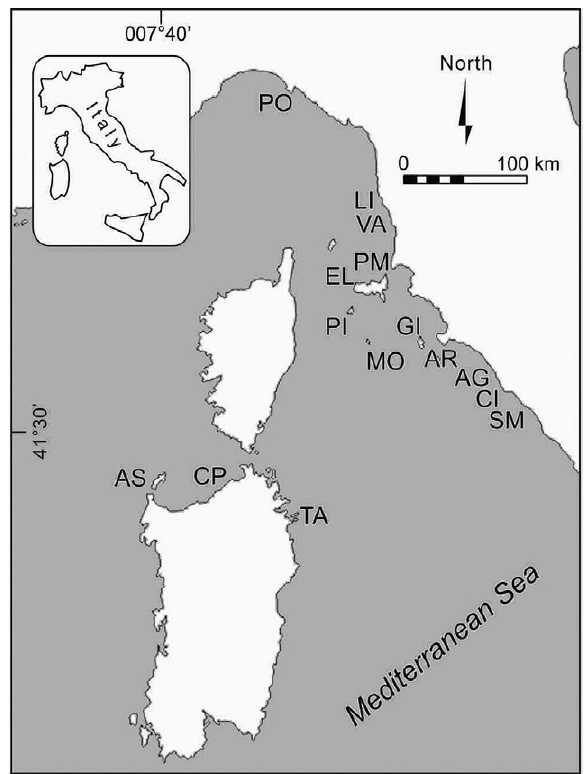
Fig. 1. – Map of the study locations: Portofino (PO), Livorno (LI), Vada Shoals (VA), Piombino (PM), Elba Island (EL), Pianosa Is- land (PI), Montecristo Island (MO), Giglio Island (GI), Argentario (AR), Sant’Agostino (AG), Civitavecchia (CI), Santa Marinella (SM), Asinara Island (AS), Costa Paradiso (CP), Tavolara Island